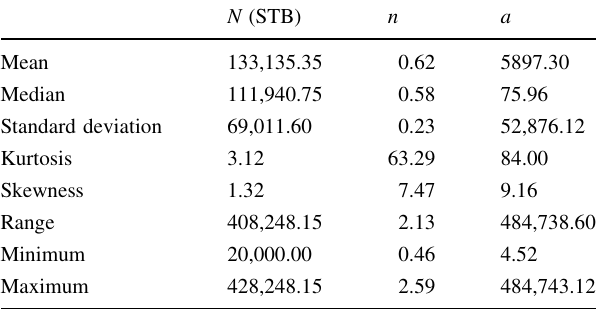
Table 4 Statistical summary of model fitting parameters for the logistic growth model